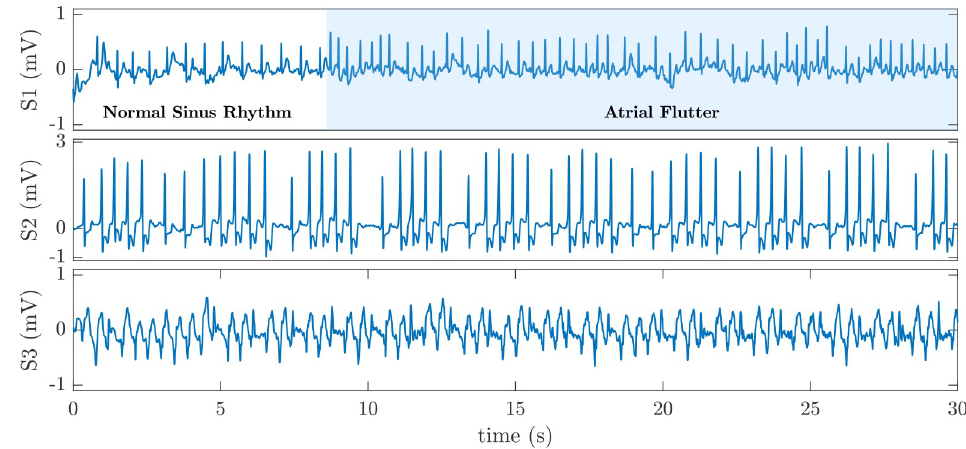
Fig 4. Examples of false-positive errors in AFib detection. S1 is a 30 s ECG signal in which an episode of atrial flutter follows an episode of normal sinus rhythm. This ECG signal is classified as AFib. S2 is an episode of NSVT that is incorrectly classified as AFib. S3 is an episode of SVT with wide QRS that is incorrectly classified as AFib.